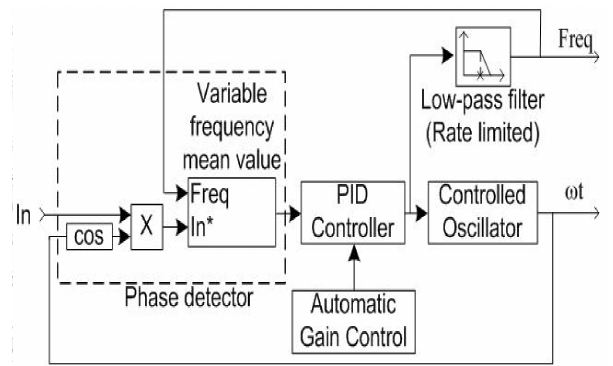
Figure 4. Phase locked loop (PLL) system. (PID: proportional–integral–derivative controller).